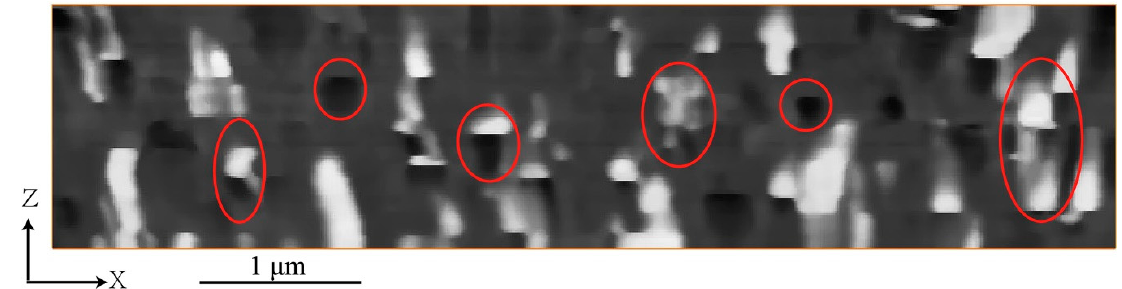
Figure 4. The 56th 2D image of the TiO 2 pigmented waterborne paint film in the XZ direction. The grey parts are acrylic resin, the white parts are TiO 2 particles, and the black parts are voids. Figures 5 and 6 show some typical voids in different forms in the measured sample in detail.